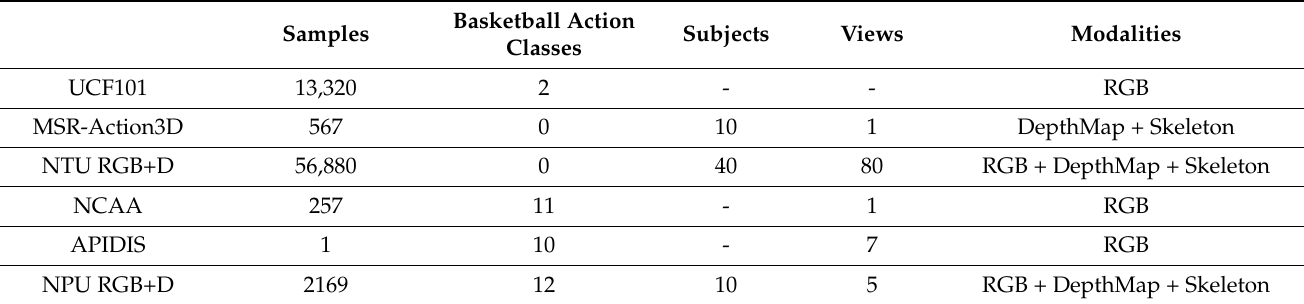
Table 1. A comparison between the NPU RGB+D dataset and several publicly available datasets for action analysis.